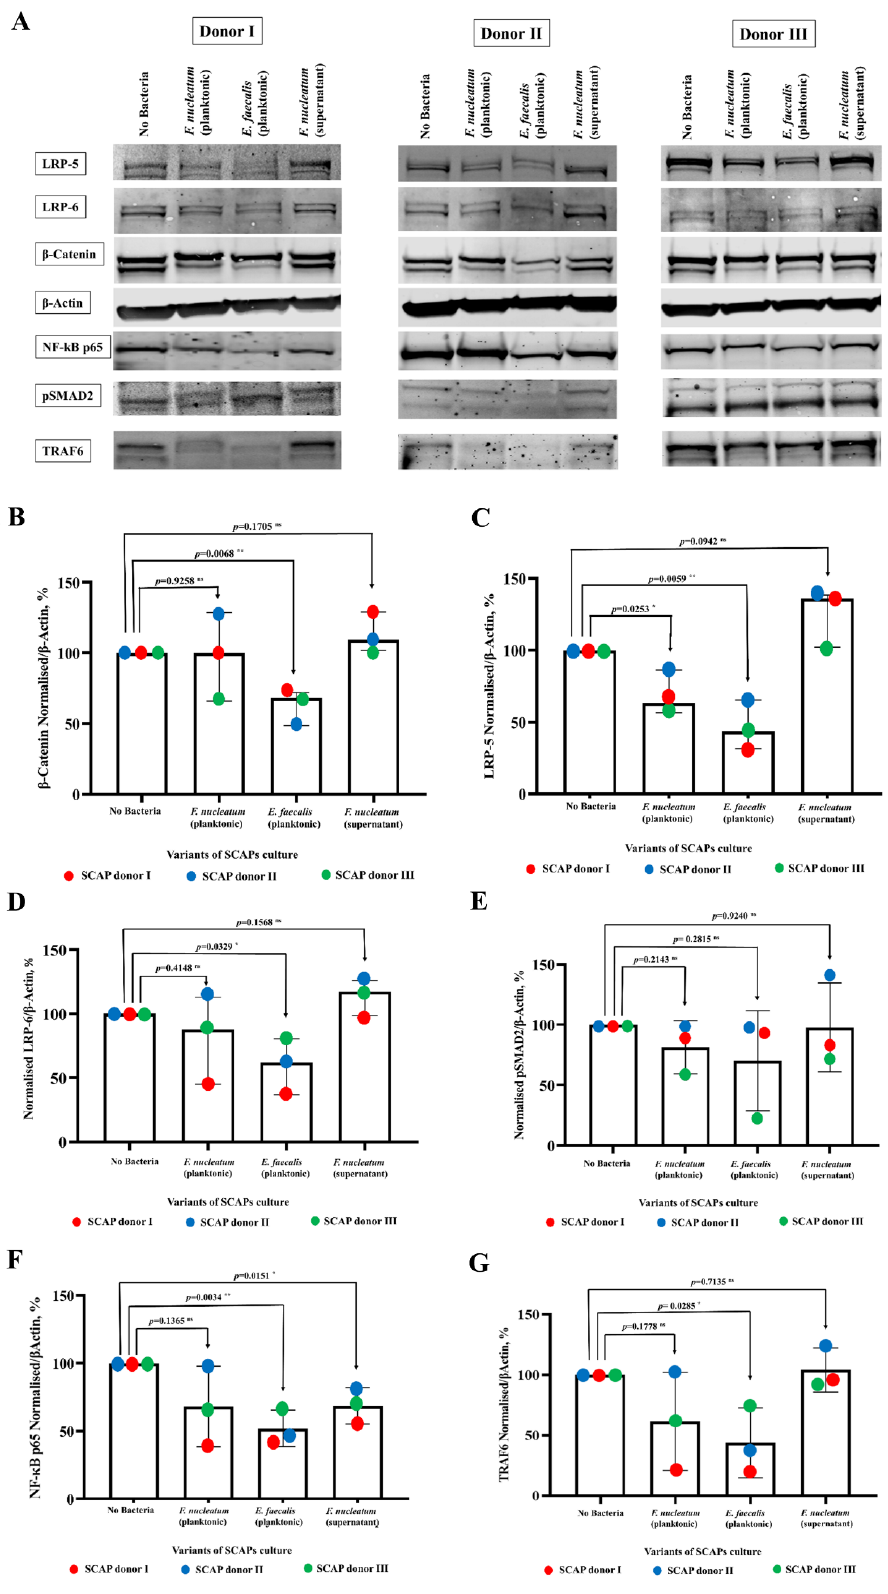
Figure 8. Alterations in expression of LRP-5, LRP-6, β -Catenin, pSMAD2, TRAF6, and NF- κ B p65 in SCAP modulated by F. nucleatum (planktonic and supernatants) or E. faecalis (planktonic). ( A ) Cells were cultured in designated conditions, collected, and lysed. Expression of listed proteins